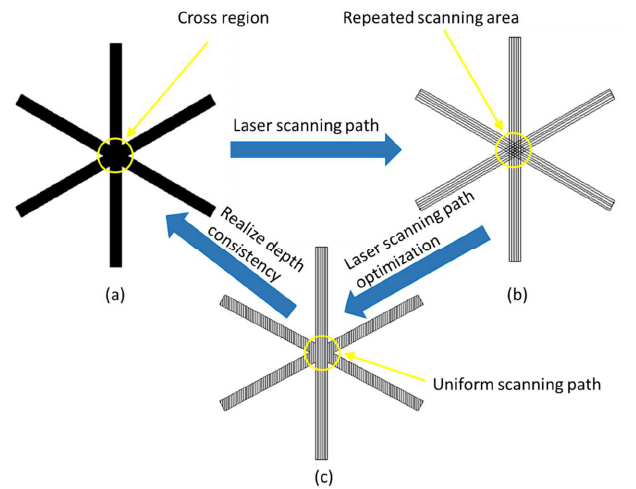
Figure 7. ( a ) The shape of the bursting disc microgroove. ( b ) Each microgroove uses a different scanning path, resulting in repeated scanning of the cross region. ( c ) Unification of scanning paths to ensure the consistency of the microgroove depth.